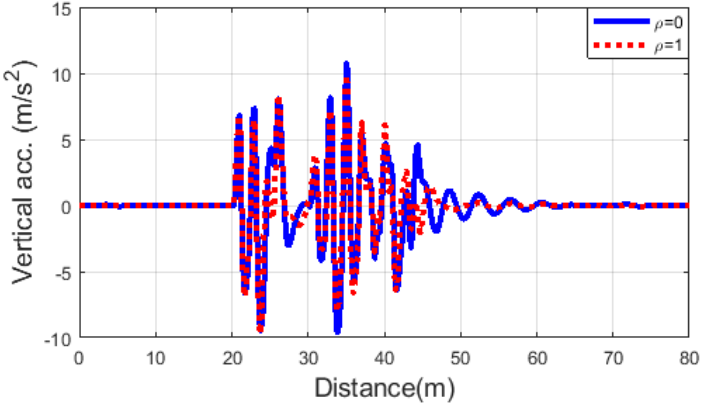
Figure 10. Vertical acceleration of several bumps.